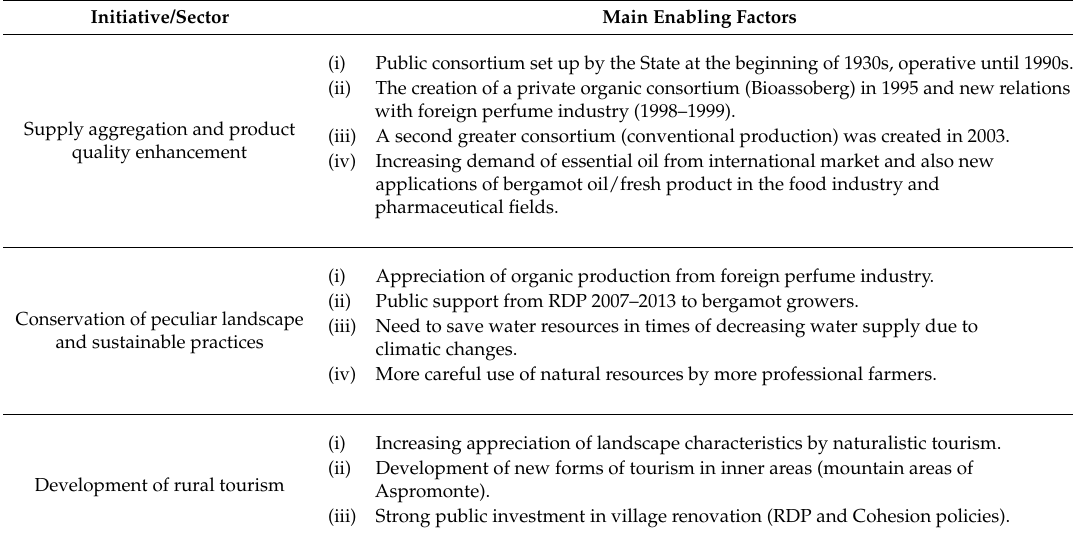
Table 4. The most relevant initiatives related to the LAFS in Grecanic